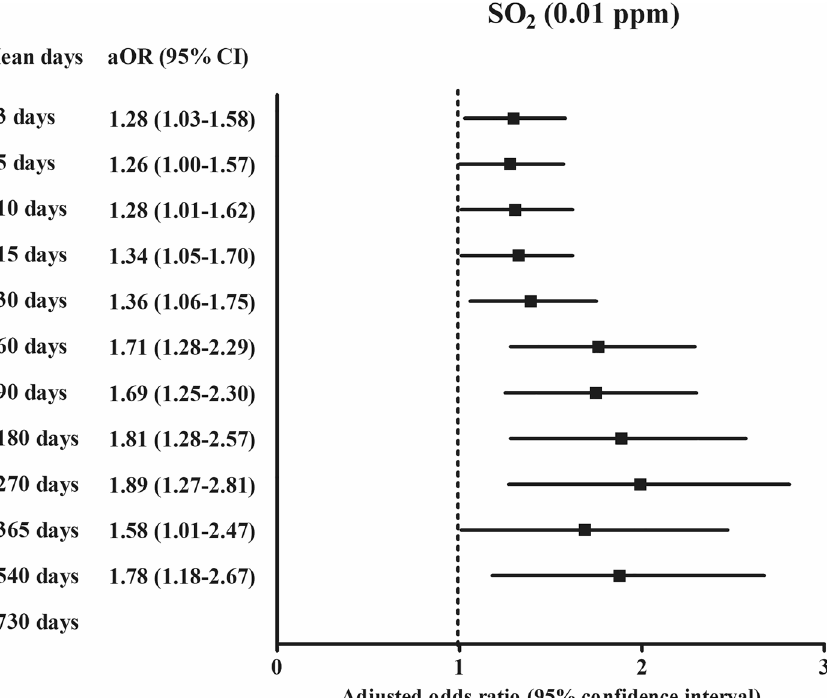
Figure 2. The odds ratios (95% confidence interval) of SO 2 (0.01 ppm) for 3 days, 5 days, 10 days, 15 days, 30 days, 60 days, 90 days, 180 days, 270 days, 365 days, and 540 days for ischemic heart